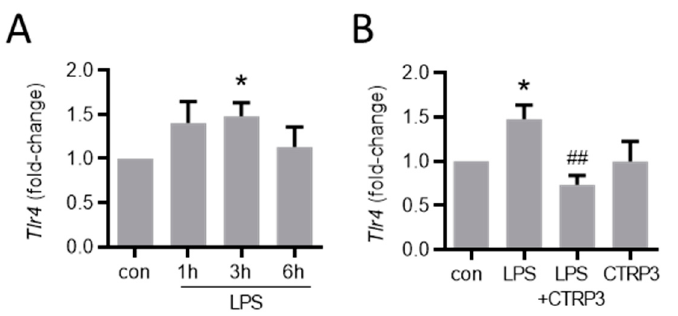
Figure A3. LPS-induced Tlr4 expression is inhibited by CTRP3. ( A ) MyEnd (myocardial endothelial) cells were stimulated with LPS (lipopolysaccharides, 50 ng/mL) for the indicated period. Tlr4 (Toll-like receptor 4) mRNA levels were analyzed by real-time PCR. * p < 0.05 vs. con = unstimulated control, n = 4–6. ( B ) MyEnd cells were stimulated with LPS (50 ng/mL) alone or pretreated with CTRP3 (C1q/TNF-related protein 3, 10 µg/mL, for 30 min) and CTRP3 alone for 3 h. Tlr4 mRNA levels were analyzed by real-time PCR. * p < 0.05 vs. con = unstimulated control, ## p < 0.01 vs. LPS, n = 4–6.